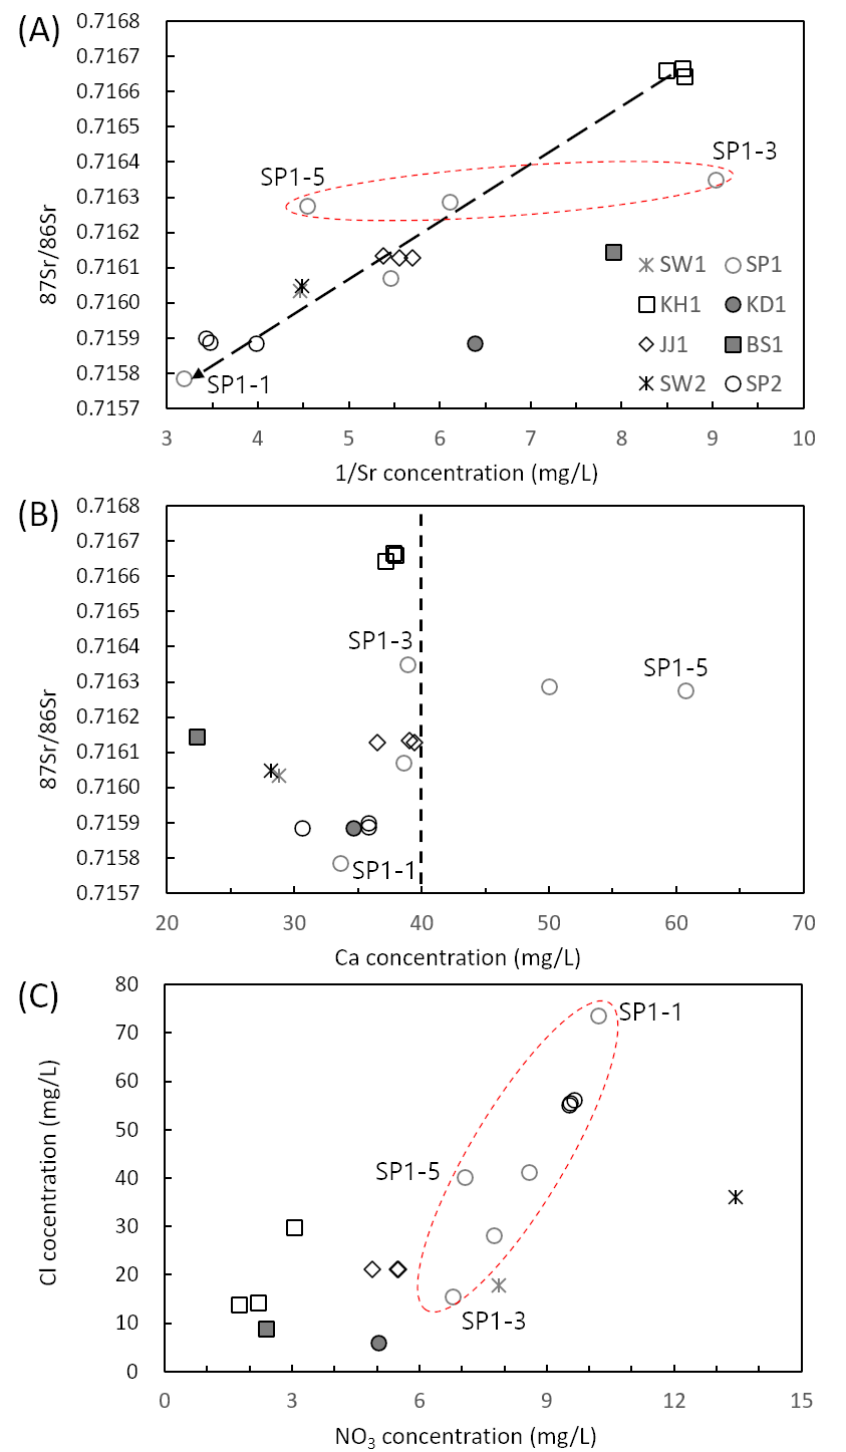
Figure 6. 87 Sr/ 86 Sr vs. 1/Sr distribution in water samples ( A ), 87 Sr/ 86 Sr vs. Ca concentration diagram ( B ), and Cl vs. NO 3 concentration diagram for water samples ( C ) before and during heating operation